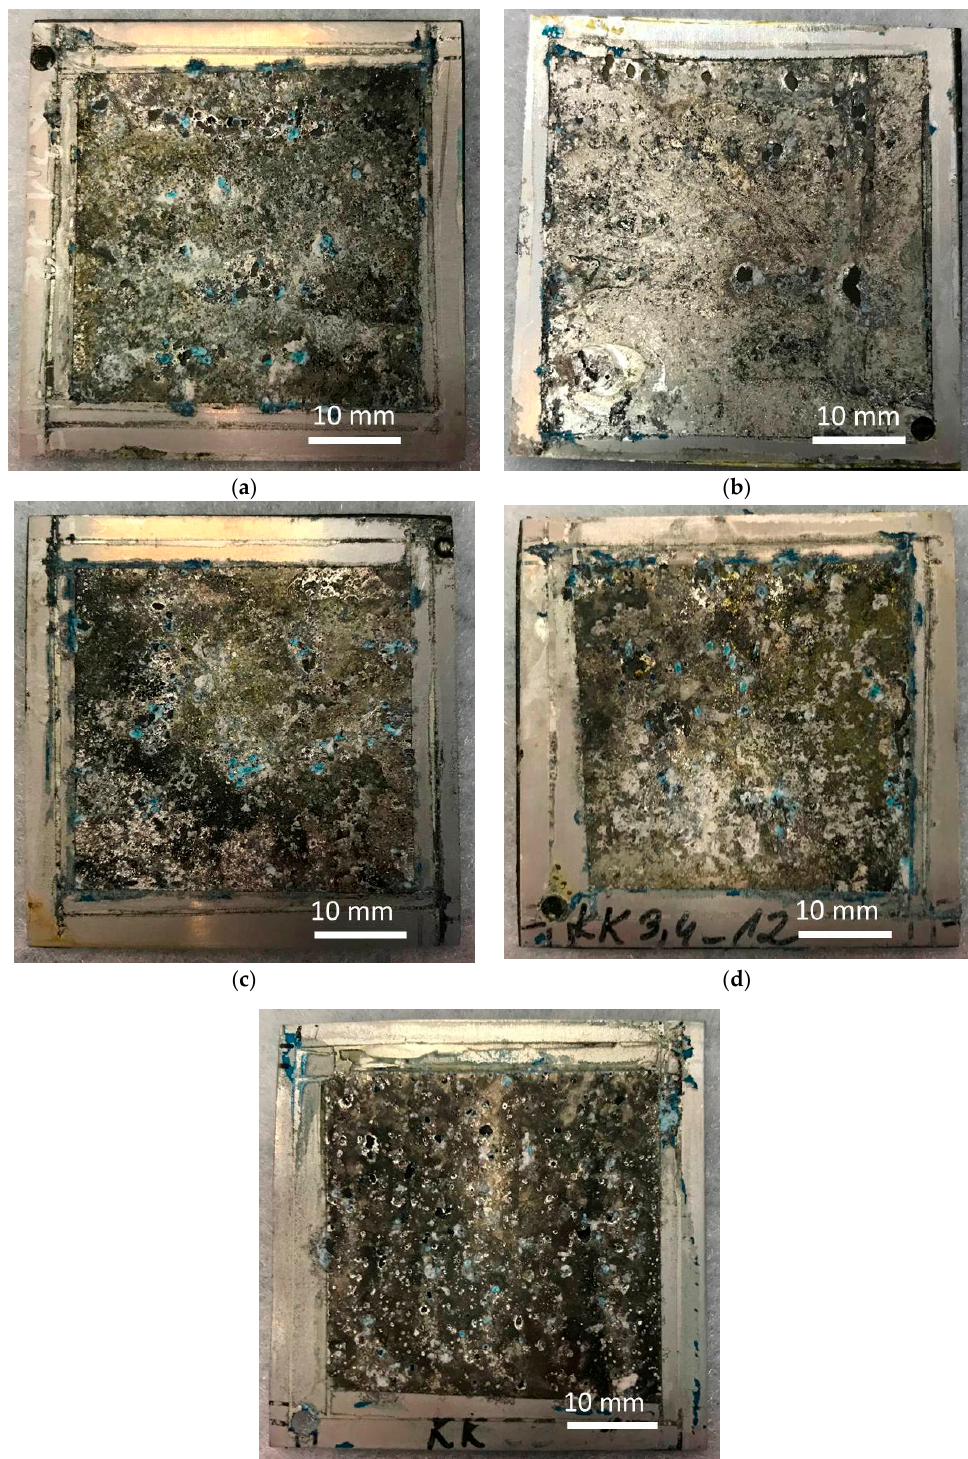
Figure 9. Laminate surface macrostructure: ( a ) Al-CFRP, ( b ) Al-CFRP reverse side, ( c ) Al-GFRP(0)-CFRP, Figure 9 . Laminate surface macrostructure: a ) Al-CFRP, b ) Al-CFRP reverse side, c ) Al-GFRP(0)- ( d )Al-GFRP(90)-CFRP,and( e )analuminumsheet, after12weeksoftestinginasaltchamber; CFRP, d ) Al-GFRP(90)-CFRP, and e ) an aluminum sheet, after 12 weeks of testing in a salt chamber; 0.8 M NaCl.